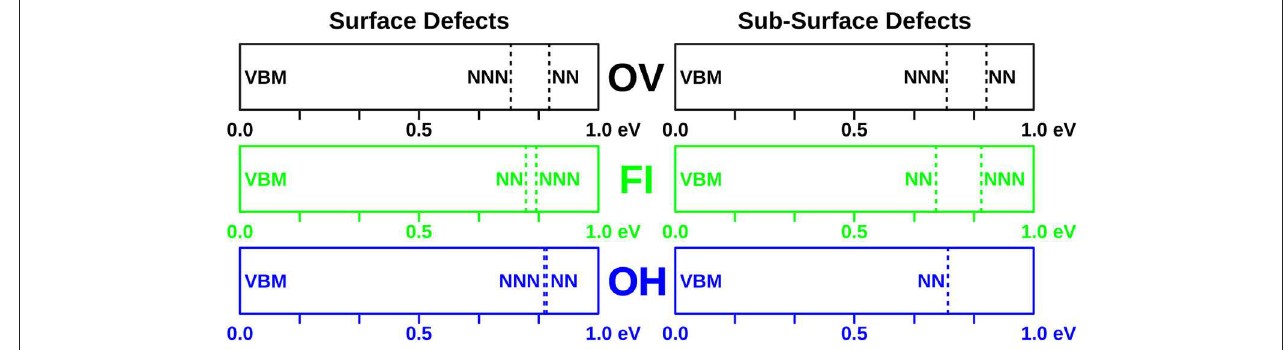
FIGURE 6 | f electron eigenvalues of the defects studied in this work. Positions of f-levels with respect to the valence band for all defects with nearest (NN) and next nearest neighbor (NNN) localization are indicated.